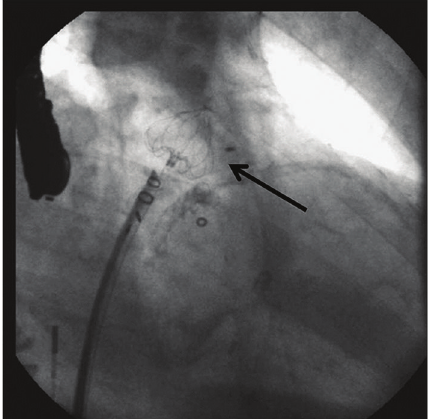
Figure 4: Fluoroscopic image of the WATCHMAN device (arrow) deployed in the left atrial